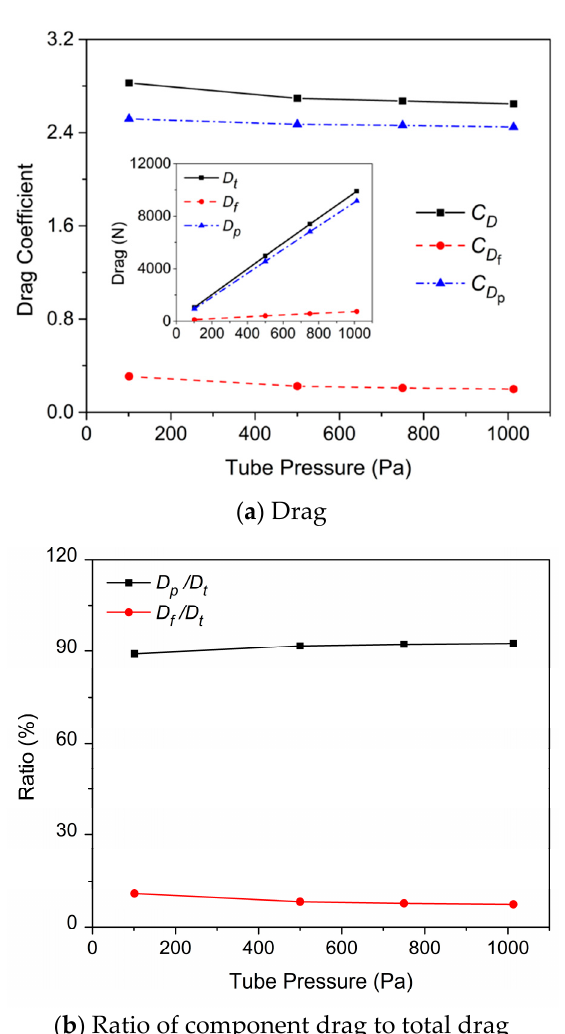
Figure 10. Effect of tube pressure: ( a ) Variation of drag and drag coefficient with respect to the tube Figure 10. E ff ect of tube pressure: ( a ) Variation of drag and drag coe ffi cient with respect to the tube pressure. ( b ) Ratios of the pressure and friction drags to the total drag. pressure. ( b ) Ratios of the pressure and friction drags to the total